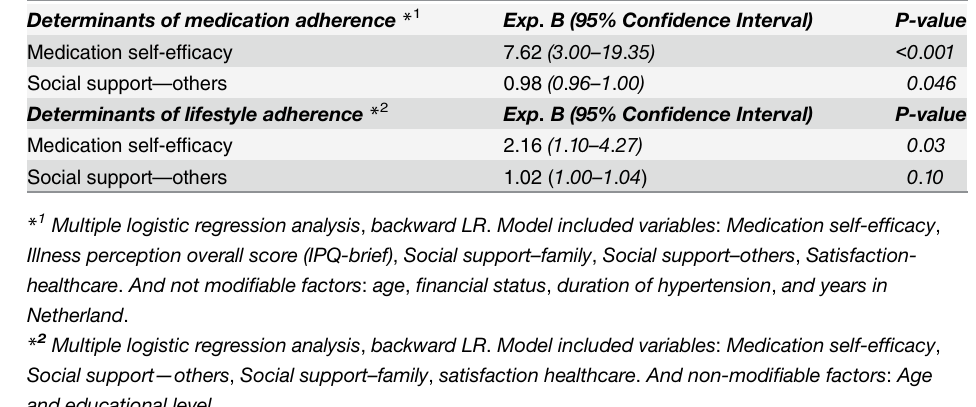
Table 2. Association between adherence to medication and lifestyle recommendations and determi- nants at start of intervention.